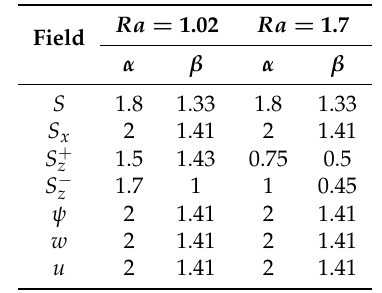
Figure 13. Pdfs of ψ , w and u for Ra = 1.02 (blue) and 1.7 (red). Parameters of the dashed stretched Gaussian curves shown alongside are given in Table 2. Table 2. Curve-fitting parameters for the probability density functions in Figures 12 and 13. Here the “ + (cid:48)(cid:48) and “ − (cid:48)(cid:48) symbols denote the positive and negative arguments of the pdfs,